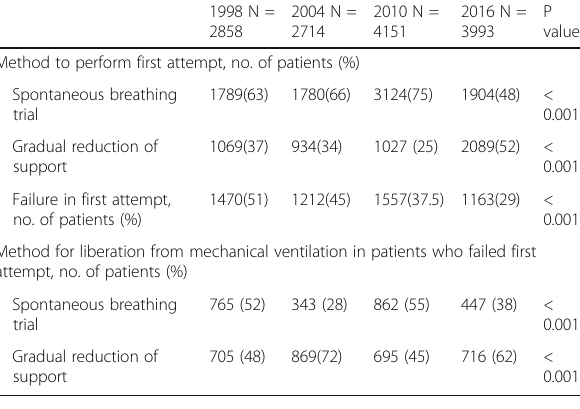
Table 1 (abstract 0142). Methods used for liberation from mechanical ventilation